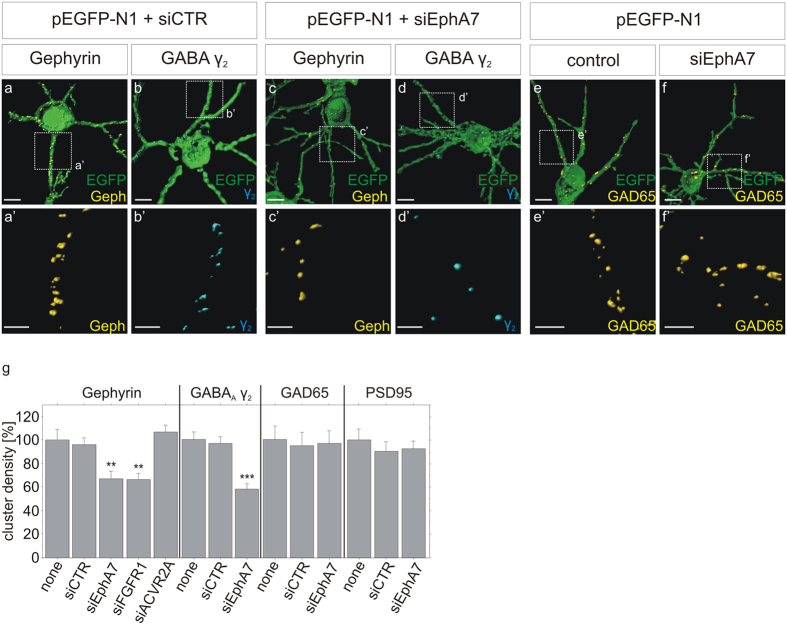
siRNA-mediated knockdown of EphA7 reduces gephyrin cluster density in hippocampal neurons.(a–g) Hippocampal neurons were cotransfected with pEGFP-N1, a scrambled control siRNA (siCTR) or siRNA specific for EphA7 (siEphA7), for FGFR1 (siFGFR1), or for ACVR2A (siACVR2). Cultures were fixed and stained for expression of gephyrin (a,c), the γ2 sub-unit of GABAA receptors (b,d) or GAD65 (e,f). Transfected cells were identified by green EGFP fluorescence. Magnifications of insets in (a–f) are shown in (a’–f’). All images were rendered using Imaris software. Scale bars, 10 μm. (g) Densities of gephyrin, GAD65, PSD95 and γ2 subunit punctae were quantified per 20 μm dendritic segment, n = 30; **p < 0.01; ***p < 0.0001; ANOVA, Fisher-PLSD. For knockdown efficiency of EphA7 siRNA see supplementary Figure S2.